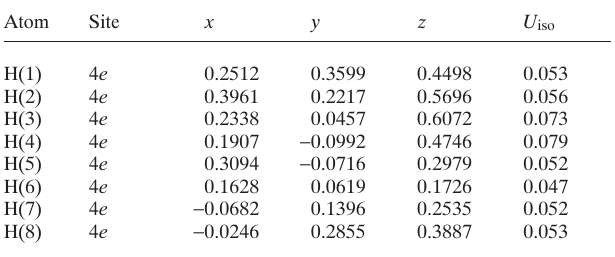
Table 4. Data collection and handling. Table 5. Atomic coordinates and displacement parameters (in Å 2 ) .